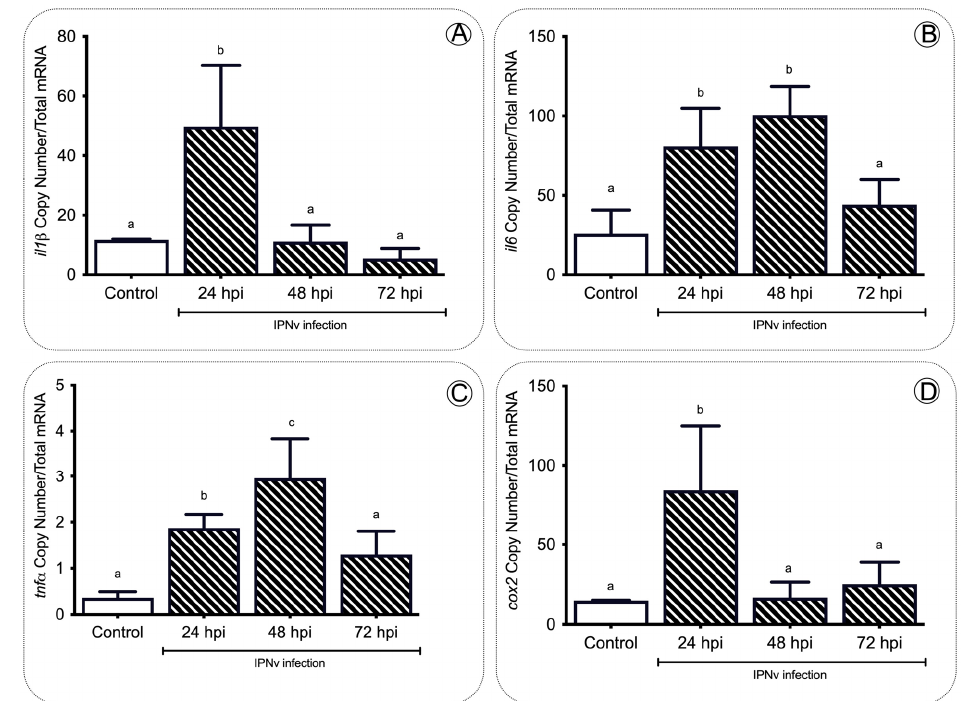
Figure 1. Expression profile of proinflammatory cytokines during infection. The tnfa ( A ), il1b ( B ), il6 ( C ), and cox2 ( D ) gene expression after IPNv infection in the hind kidney of salmon. Control sample corresponds to unchallenged fish. Data represent the mean ± SEM. One-way ANOVA; p < 0.05 was considered statistically significant. Different letters denote significant differences.